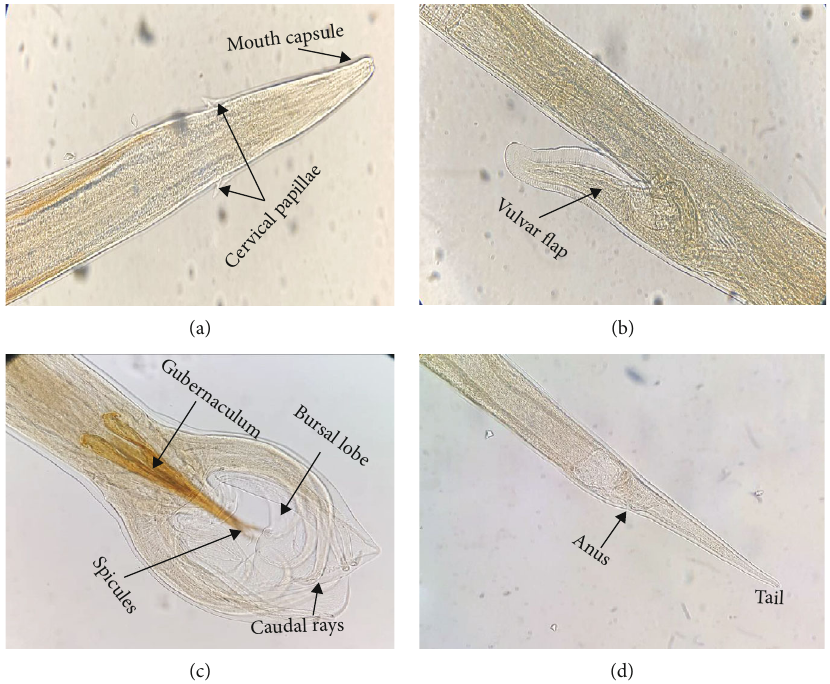
Figure 3: Haemonchus contortus : (a) anterior end showing cervical papillae; (b) knobbed vulvar fl ab of female; (c) bursa of male showing dorsal rays and spicules; (d) posterior end of female showing the anus and